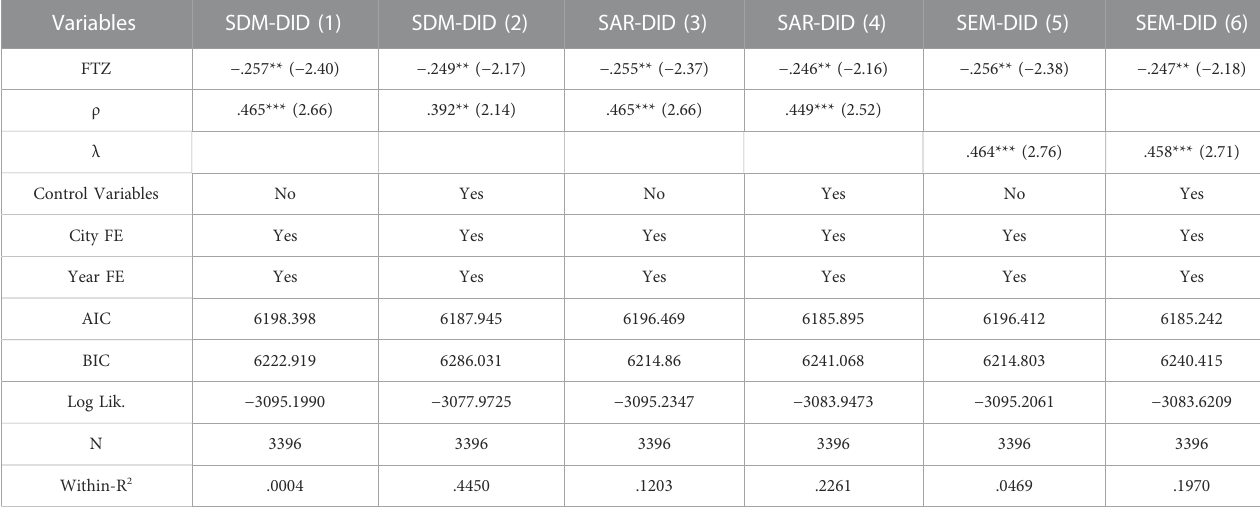
TABLE 6 Results with NOX as the response